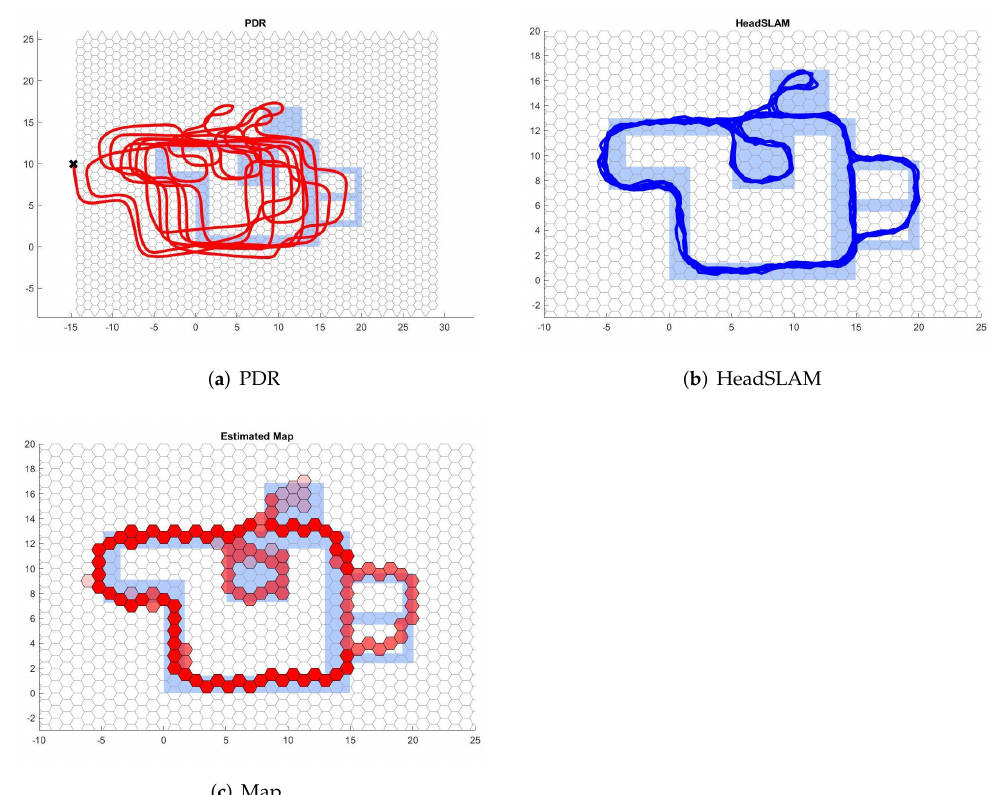
Figure 4. Indoor test results’ example. The light blue shape is the passable area extracted from the floor plan and acts as a reference for the outcomes generated by the PDR and HeadSLAM. Red lines in ( a ) represent the trajectory estimated by the PDR method. Blue lines in ( b ) show the trajectory of the particle with the highest weight in SLAM. Red hexagons in ( c ) represent the trajectory map generated by HeadSLAM, with darker shades representing those with a higher visiting